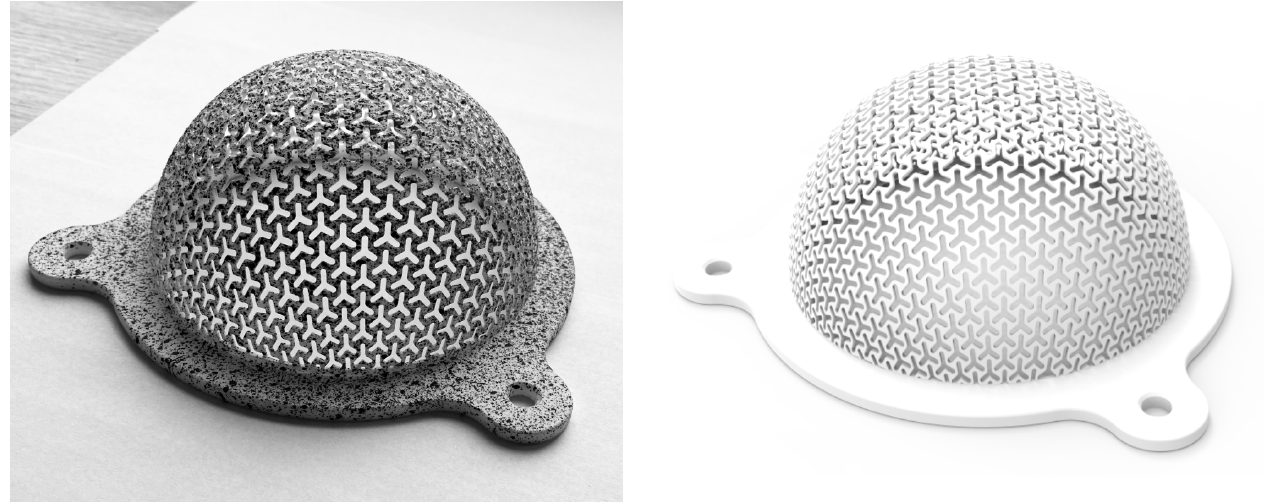
Figure 3. Printed specimen A with a spot pattern for DIC method ( left ) and visualization of geometric model ( right